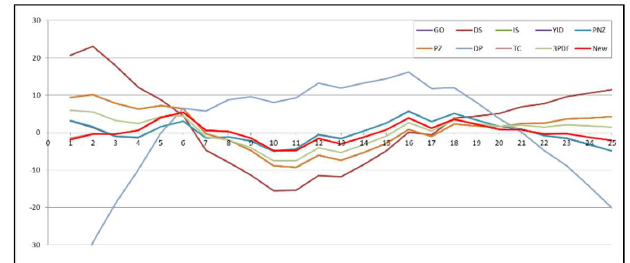
Figure 8. Relative error of the ten models for DS1.